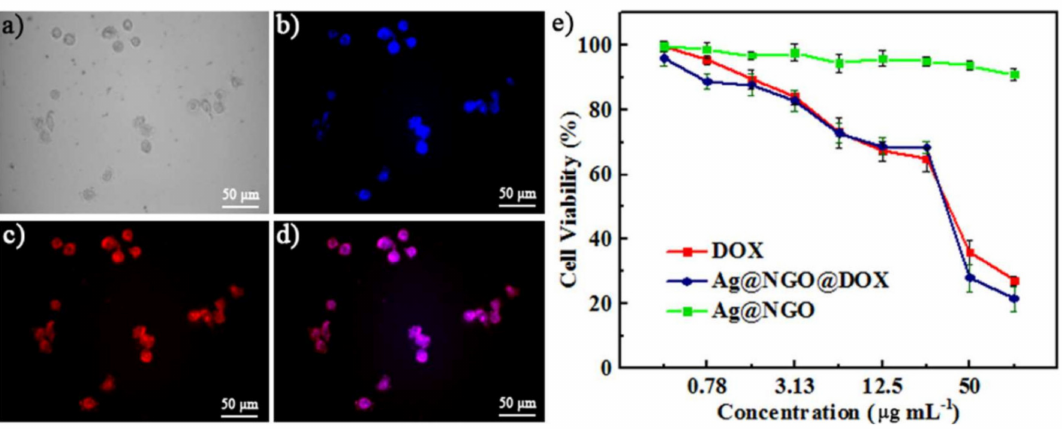
Figure 6. Fluorescence microscopy images of cancer cells HepG-2 after incubation with Ag-NGO-DOX (12.5 µ g/mL): ( a ) bright field; ( b ) blue emission ( λ ex = 360 nm ± 20 nm) of the cell nucleus after staining with 4 (cid:48) ,6-diamidino-2-phenylindole (DAPI); ( c ) red fluorescence emission of DOX inside the cells, by excitation at λ ex = 490 ± 20 nm; ( d ) overlapping of ( b , c ), showing that DOX reached the cancer cells’ nucleus; (e) MTT assay viability results of HepG-2 liver cancer cells after incubation with different concentrations (0, 0.78, 1.56, 3.13, 6.25, 12.5, 25, 50, and 100 µ g/mL) of free DOX, Ag-NGO, and Ag-NGO-DOX. Reproduced from [74], with permission from American Chemical Society,